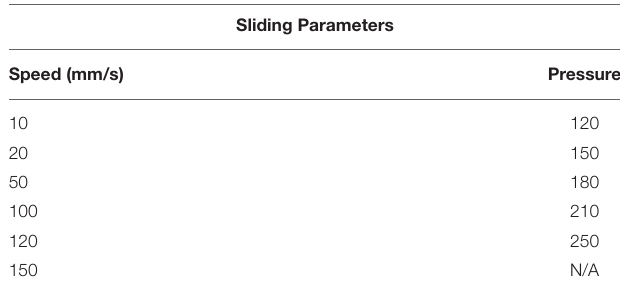
TABLE 1 | Combinations of sliding parameters are chosen from this